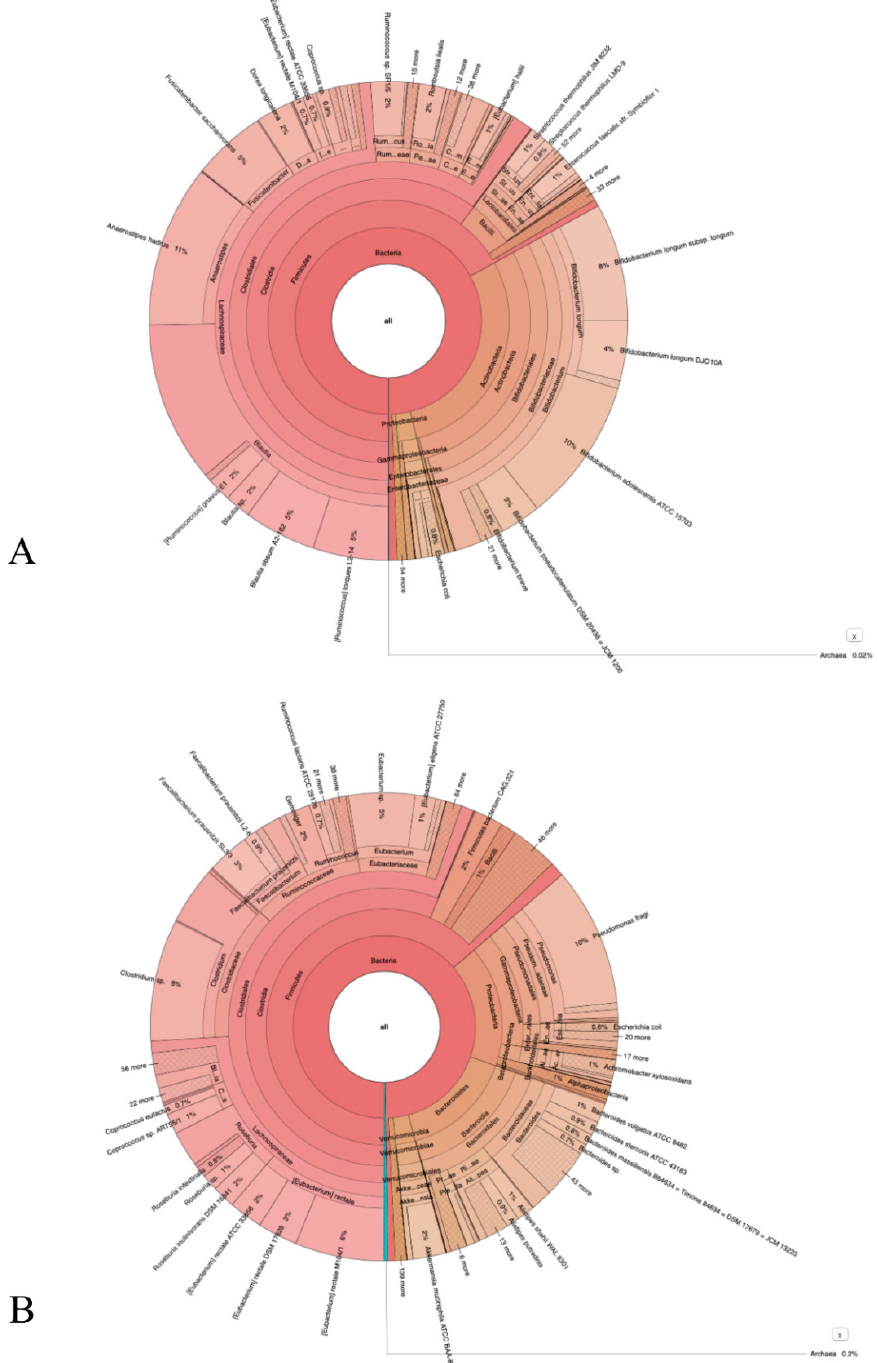
Figure 3. Panel ( A ): represents the phylum of bacteria present in the culture before the addition of SARS-CoV-2, while panel ( B ) represents the change in bacterial population after 30 days of the same cultures infected with SARS-CoV-2. For more detail see supplementary materials.